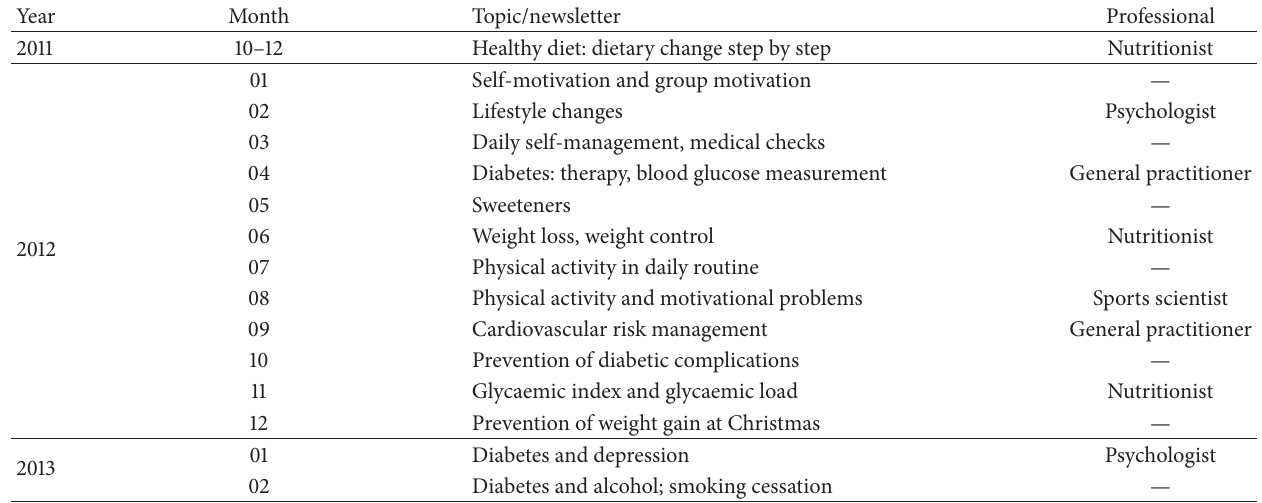
Table 1: Topics for the group meetings and